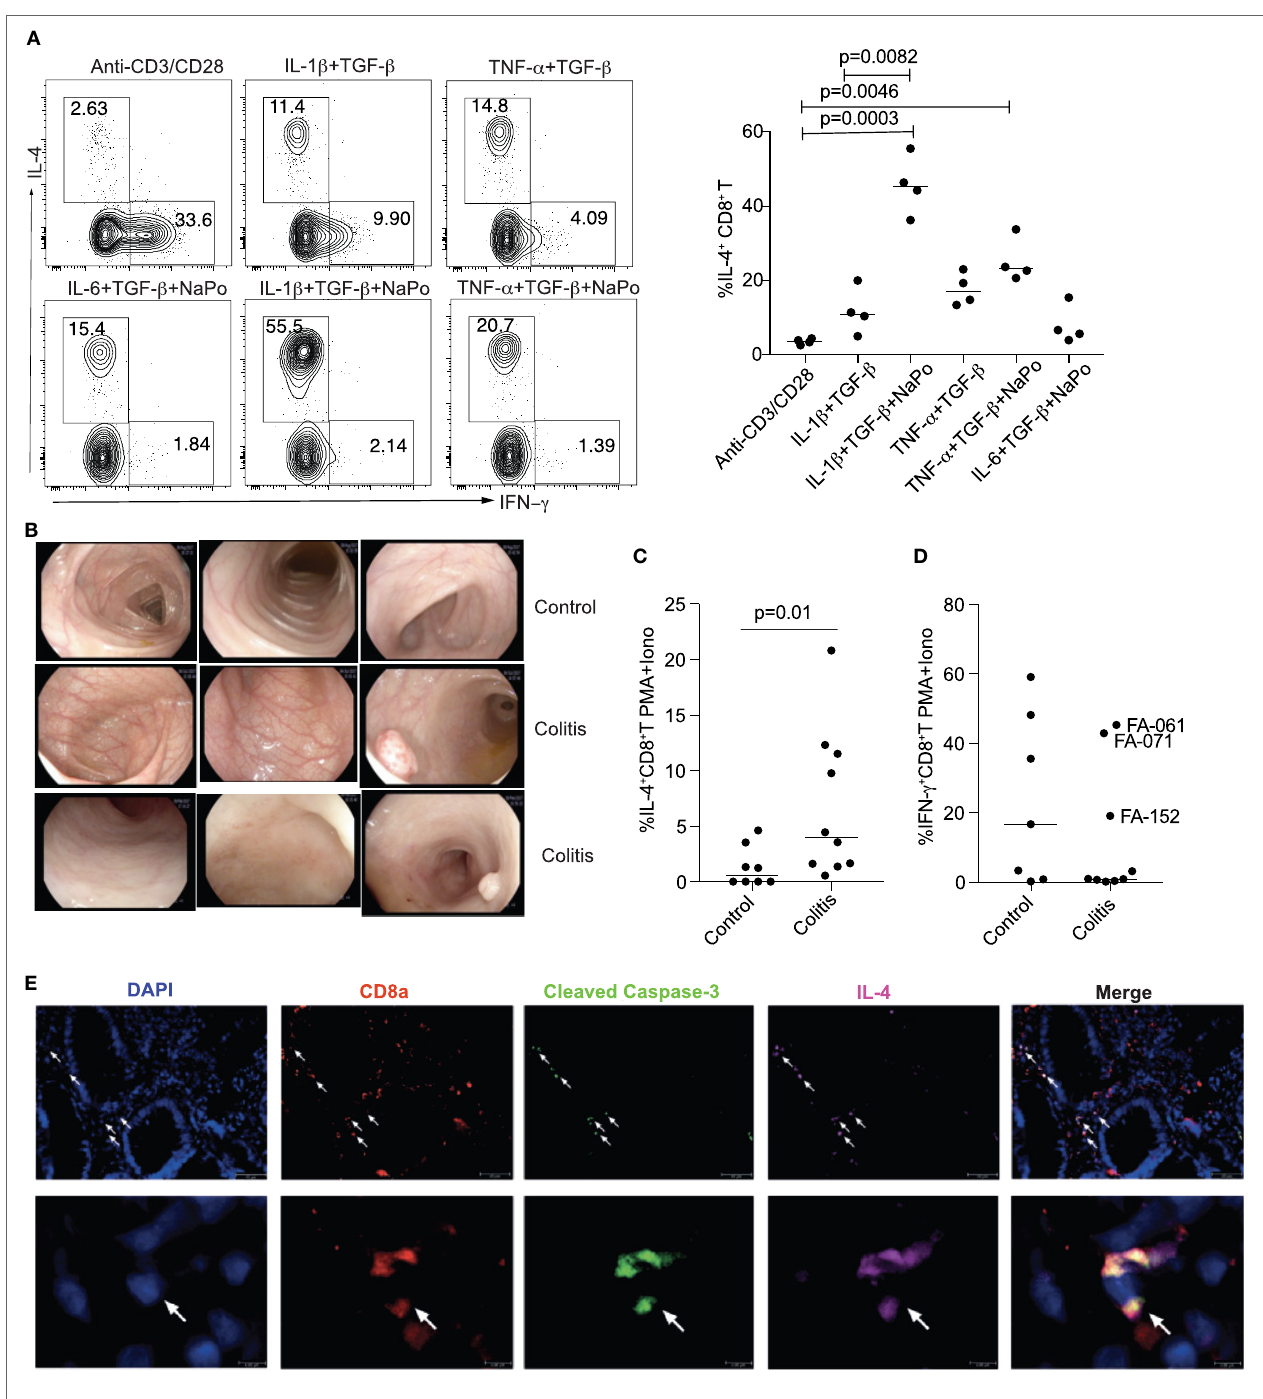
FigUre 7 | “T C 2” differentiation is increased in colonic mucosa of children with colitis. (a) “T C 2” differentiation in naïve CD8 + T cells isolated from children with non-inflammatory bowel disease and non-infectious pediatric idiopathic colitis (PIC). (B) Representative endoscopic images of colonic mucosa from control children and children with PIC. (c,D) Intracellular expression of IL-4 and IFN- γ in CD8 + intraepithelial lymphocytes from colonic mucosa following stimulation with PMA and ionomycin. P -value was calculated by Mann–Whitney U test. (e) Expression in situ of CD8, activated caspase-3, and IL-4 in paraffin-embedded sections of colonic biopsies. Data are representative of n > 3 independent